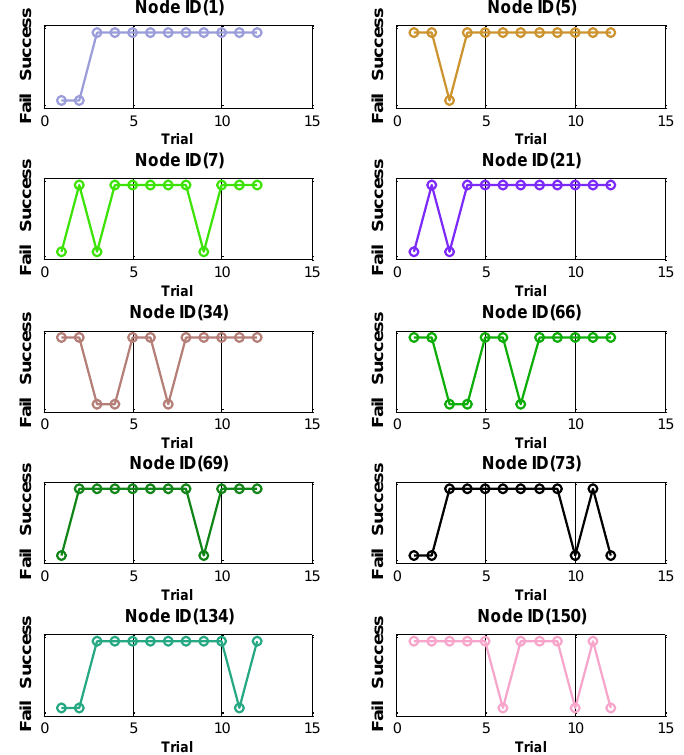
Figure 2. Application test under identical communication circumstances.